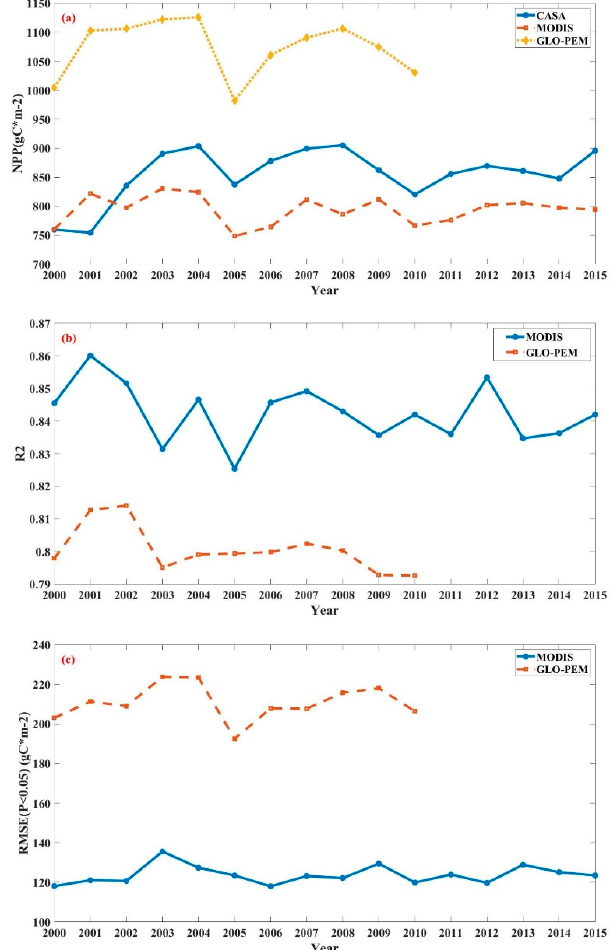
Figure 4. Comparison of the NPP calculation results with the MODIS-17A3HGF data during 2000–2015, and with the GLO_PEM data during 2000–2010,respectively: ( a ) temporal changes in the estimated NPP obtained using the CASA model and the NPP from MODIS and GLO-PEM, ( b ) the R 2 of the CASA-NPP fitted by the MODIS-NPP and GLO_PEM-NPP, ( c ) the RMSE t of the CASA-NPP fitted by the MODIS-NPP and GLO_PEM-NPP.